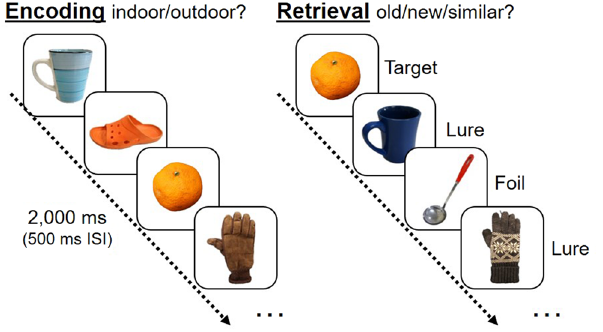
Figure 1. Mnemonic Discrimination Task. Encoding phase was an indoor/outdoor judgment task. Recognition was an old/similar/new judgment task using targets, foils and similar